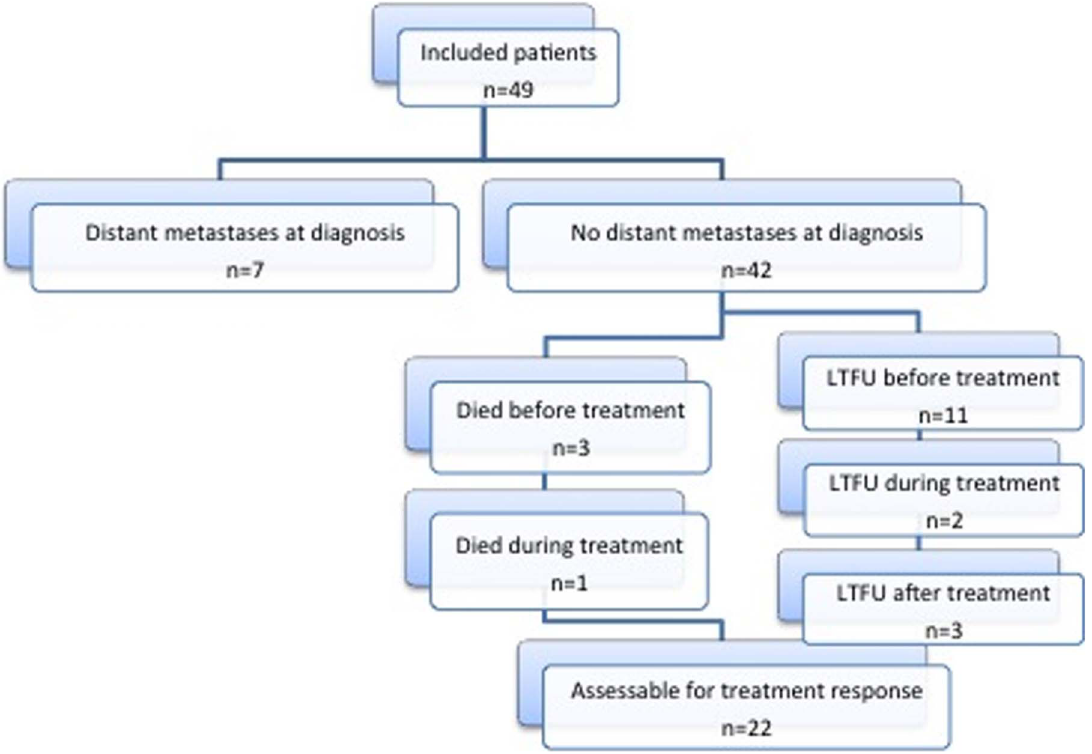
Figure 1. Patient overview. LTFU= lost to follow-up. doi:10.1371/journal.pone.0102353.g001 PLOS ONE |